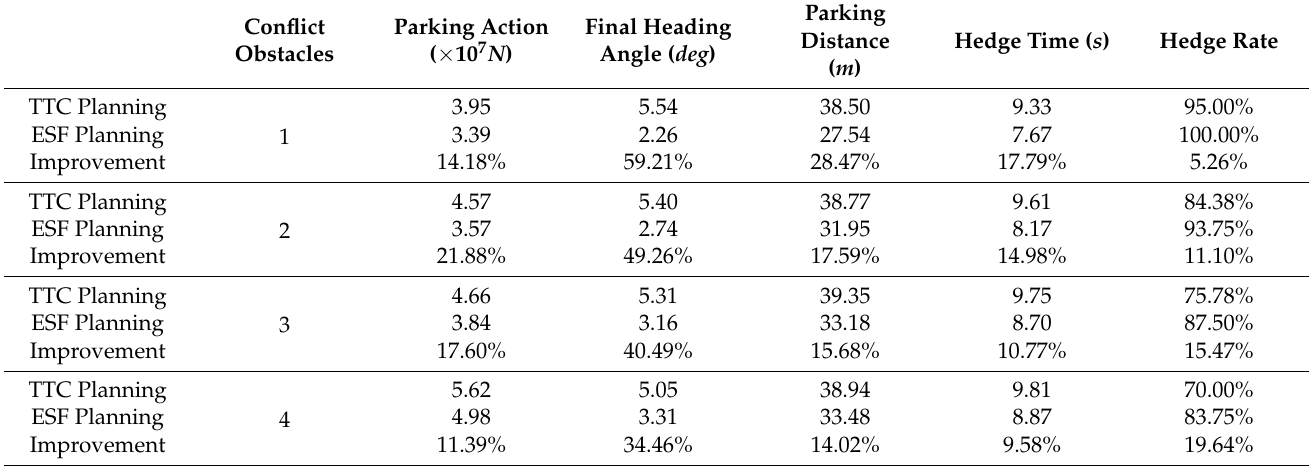
Table 1. Comparison experiment results of emergency danger avoidance